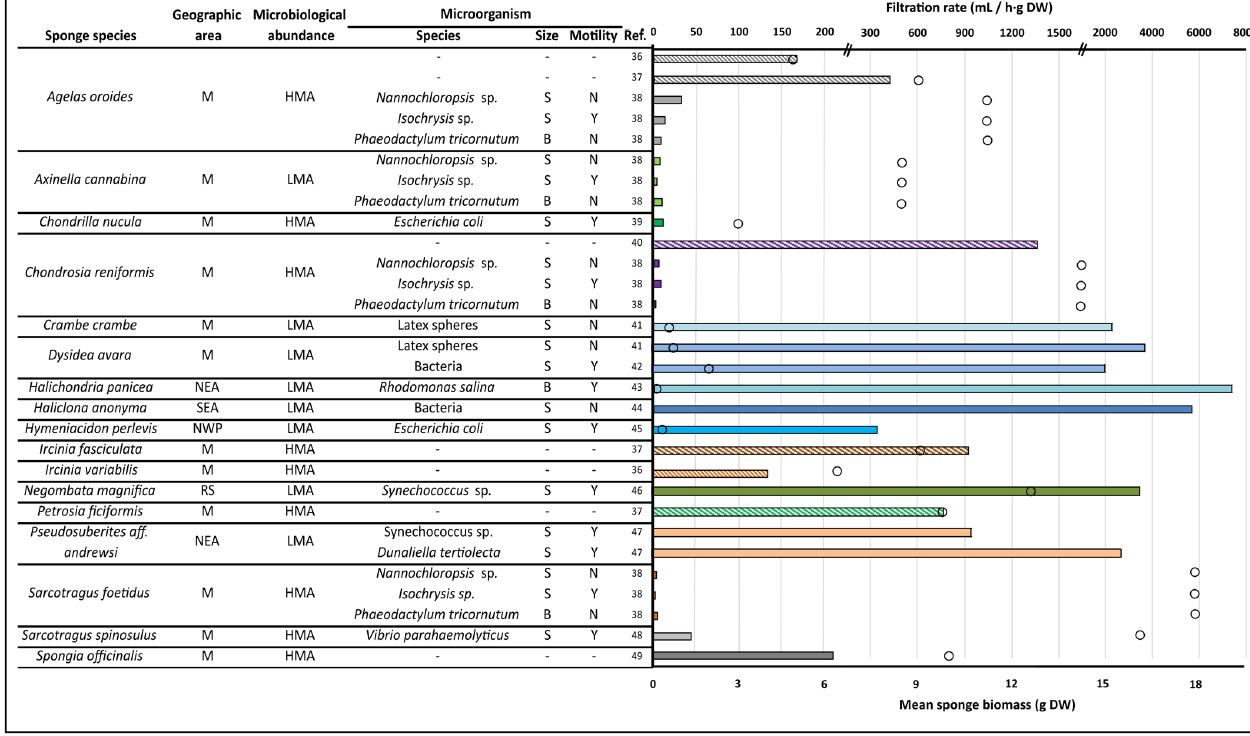
Figure 1. Comparison of sponge filtration rates (bars) according to species, explant biomass (circles), and microorganism characteristics. The cited bibliographic references are shown in the ref column [36–49]. Rayed bars represent in situ studies where no specific microorganism was used. When standardizing explant size and filtration rates, volume-to-weight and weight-to-weight conversions were made based on [50,51], respectively. Microbiological abundance classification was that de- scribed in [52]. M (Mediterranean), NEA (North-eastern Atlantic), SEA (South-eastern Atlantic), NWP (North-western Pacific), and RS (Red Sea) for the geographic area; HMA (High Microbiolog- ical Abundance) and LMA (Low Microbiological Abundance) for microbiological abundance and S (Small, <15 µm), B (Big, >15 µm), Y (motile), and N (non-motile) for microorganism description are the abbreviations used.